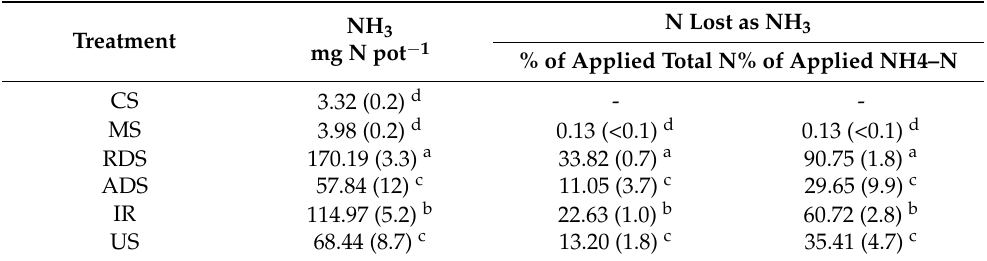
Table 1. Cumulative NH 3 emissions (mg N pot –1 ) as a percentage of total N and NH 4 –N applied (excluded control emission). Values followed by different letters in the same column are significantly different ( p < 0.05) based on the Tukey test. Standard error values are displayed in parentheses (mean, n = 3).